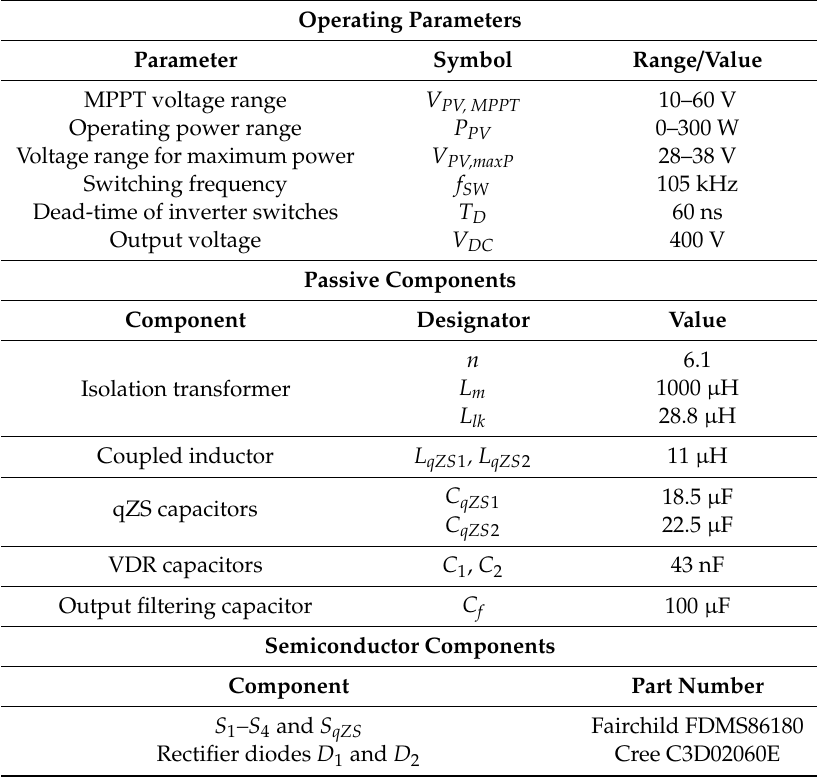
Figure 1. Power circuit topology of the case study qZS IBBC based performance metric of the PV microconverters (PVMIC). Table 1. Specifications of the case study qZS IBBC based